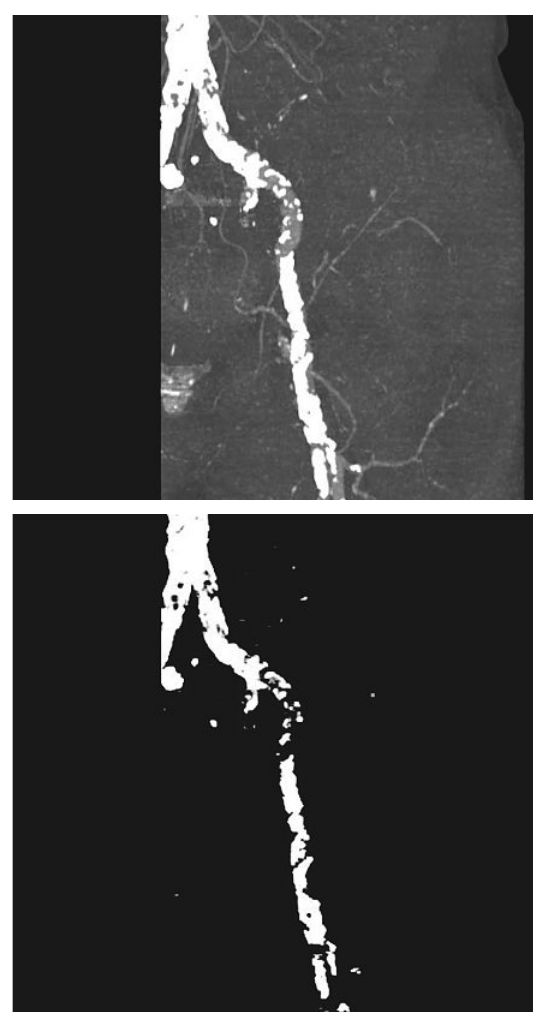
Top: A Coronal Maximum Intensity Projection Image (MIP) displaying heavy calcified left femoral and iliac artery – prohibitive forTAVI. Bottom: MIP image displaying only the burden of calcifica- tion in the left iliofemoral system.